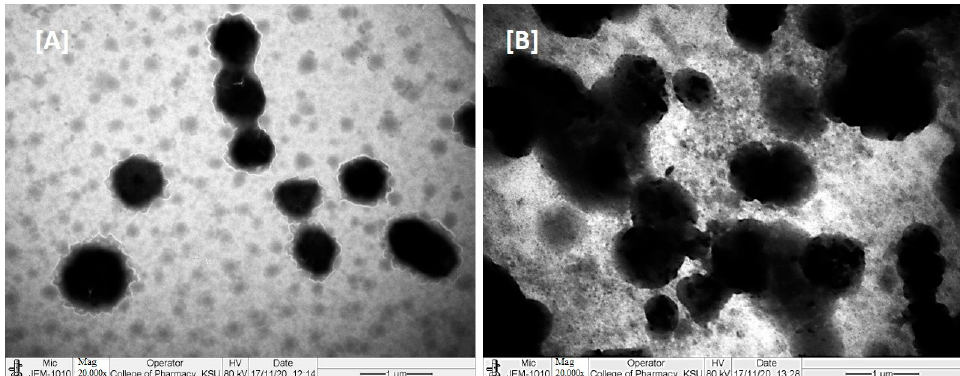
Figure 6. TEM images of RMV- and BRB-loaded representative formulations (( A ) represents F4- formulation systems and ( B ) represents F5-bio-SNEDDS).